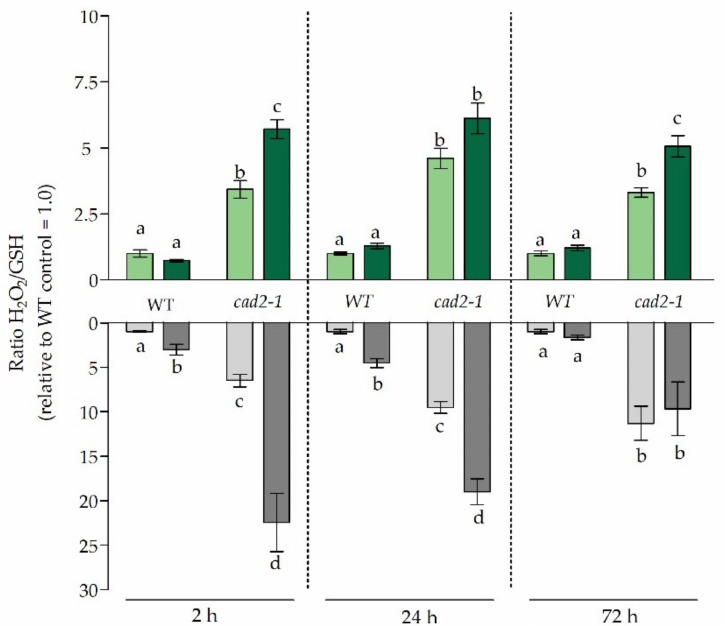
Figure 4. Relative H 2 O 2 /GSH ratio in leaves (green bars) and roots (grey bars) of 3-week-old wild- type (WT) and cad2-1 mutant Arabidopsis thaliana plants grown under control conditions (0 µ M CdSO 4 , light bars) or exposed to 5 µ M CdSO 4 (dark bars) during 2 h, 24 h, and 72 h. Data are presented as the mean ± S.E. of at least three biological independent replicates relative to the control of the WT set at 1.00 set. Significant differences (2-way ANOVA: p < 0.05) within each time point are indicated with different